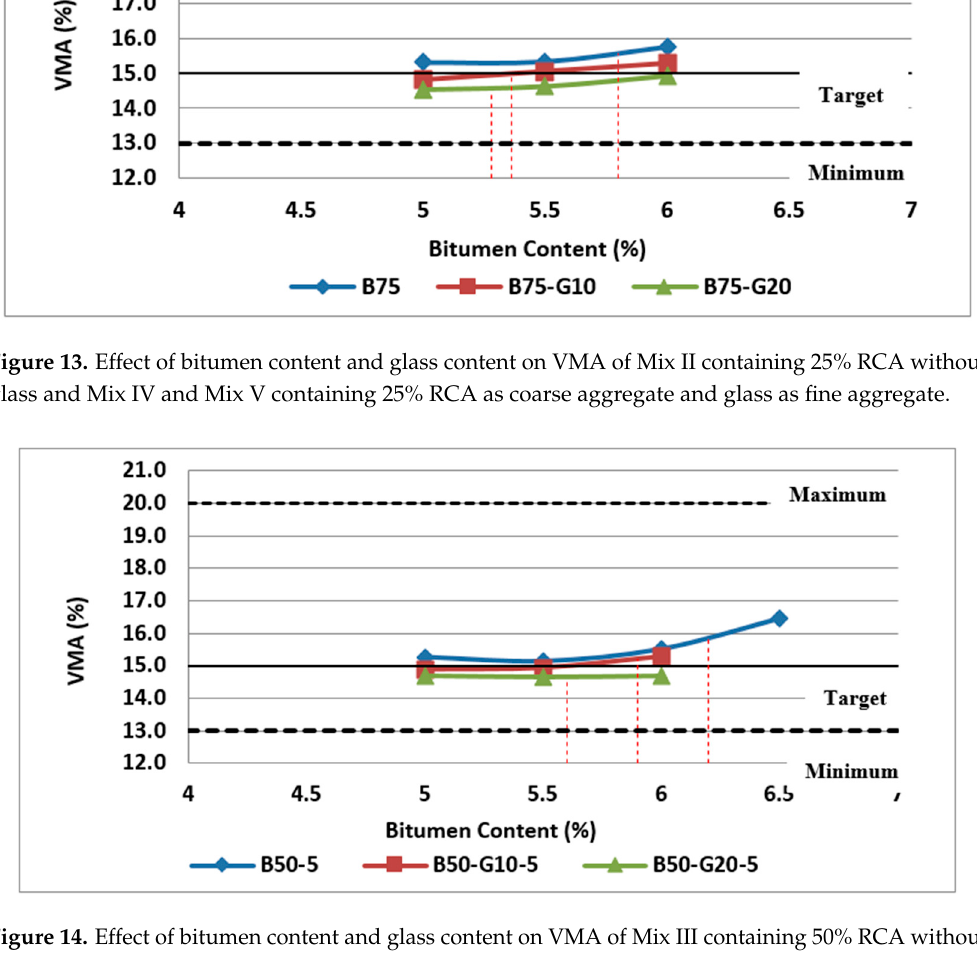
Figure 14. Effect of bitumen content and glass content on VMA of Mix III containing 50% RCA without glass and Mix VI and Mix VII containing 50% RCA as coarse aggregate and glass as fine aggregate.